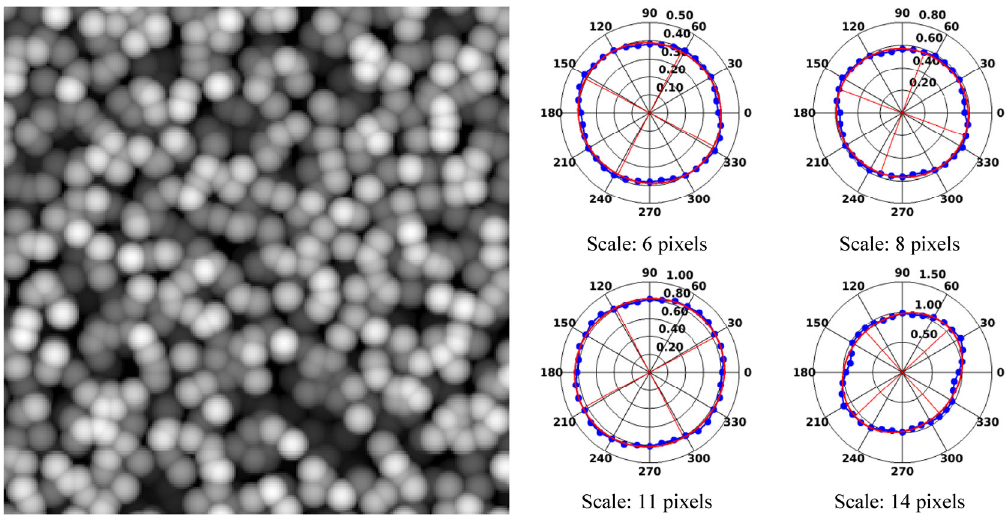
Fig. 5 Image of the self-structured surface together with the DFS analysis results using augmented blanket with rotating grid method (adapted from Ref.